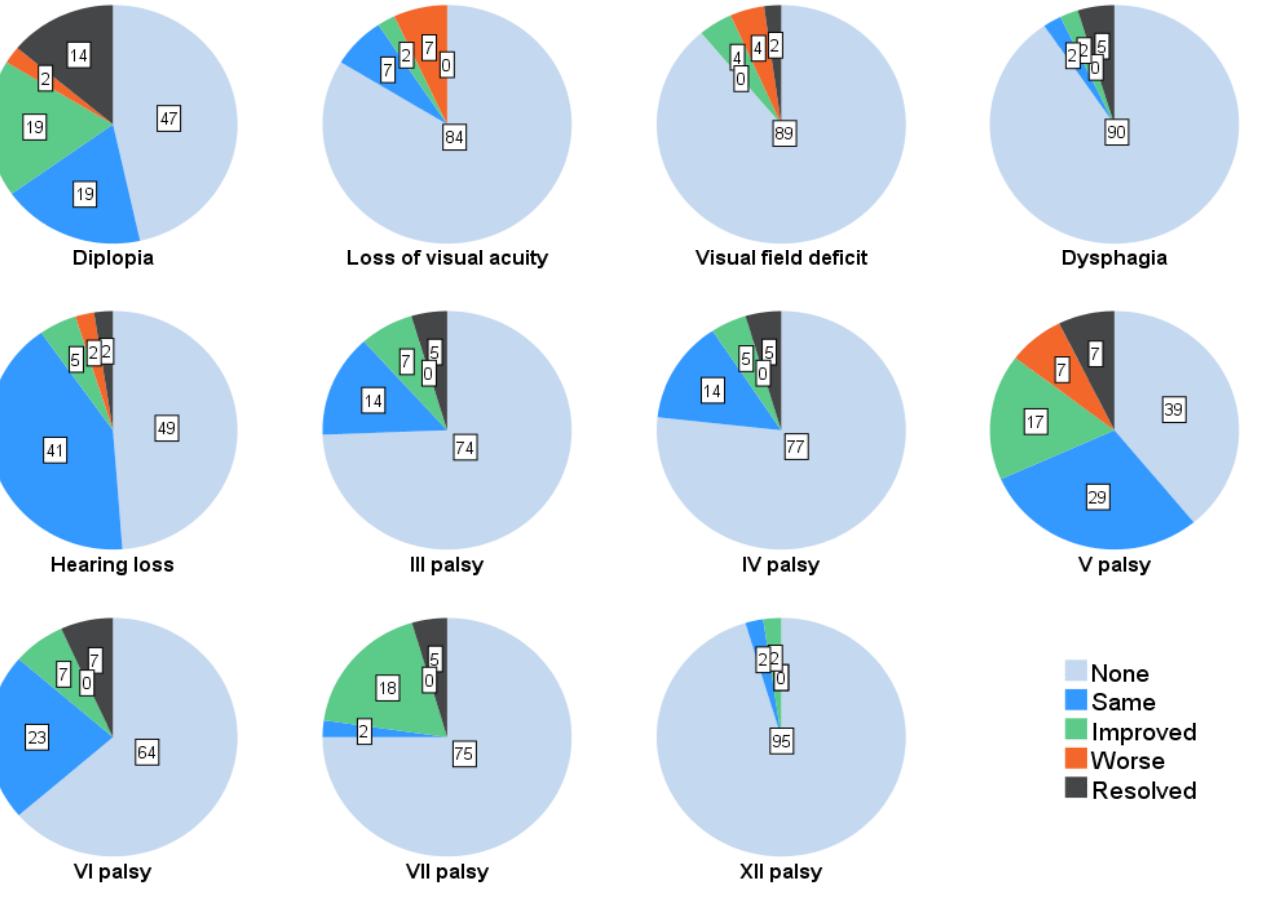
Figure 5. Proportions (%) of all patients with complaints and cranial nerve palsies on last follow up compared to status at discharge.